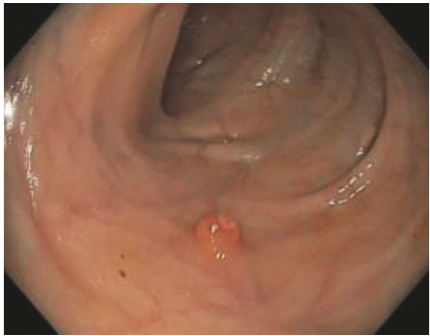
Figure 2: Preprocessed frame.